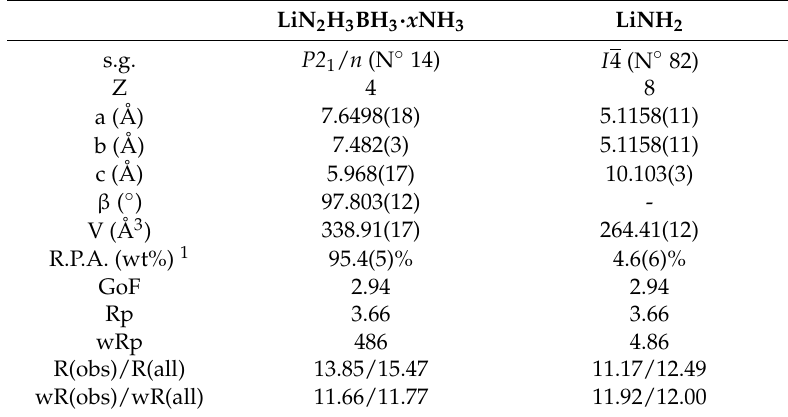
Table 1. Space group (s.g.), unit cell parameters, goodness of fit, and R-values for the refined structures for 3 (LiN 2 H 3 BH 3 · x NH 3 ) and 2 (LiNH 2 ) at room temperature.